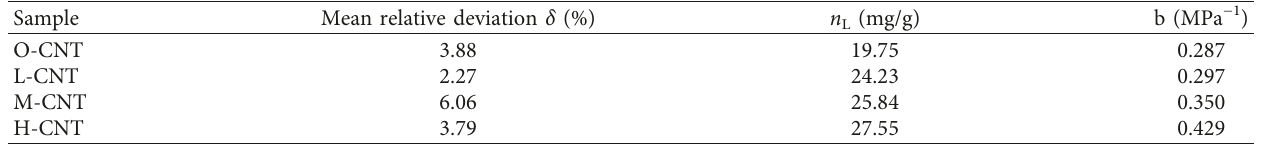
Table 2: Langmuir parameters of equilibrium isotherms for methane adsorption.